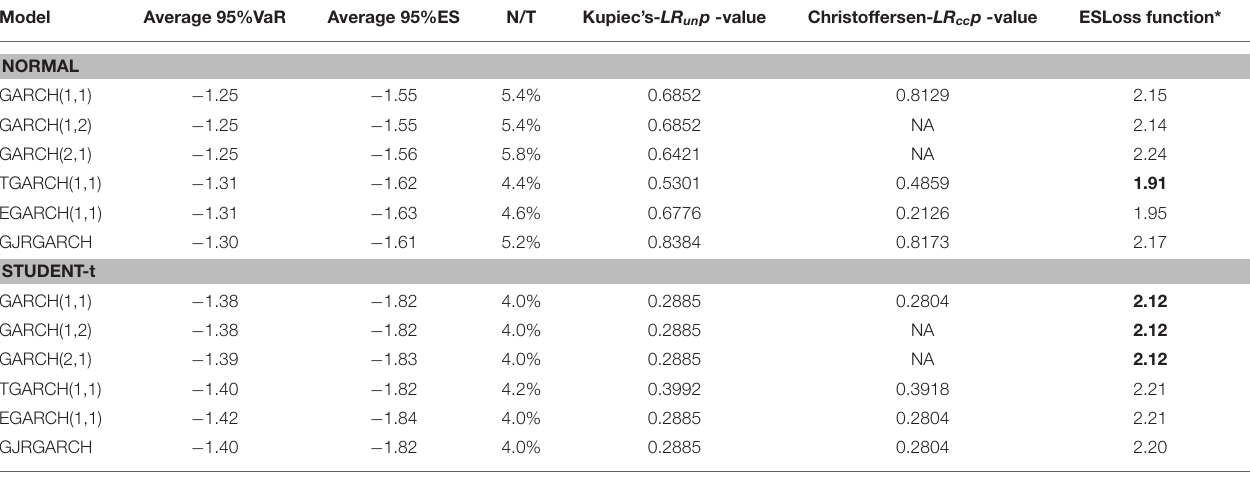
TABLE 8 | FTSE equity index: 95%VaR and 95%ES average values of one-day-ahead forecasts, percentages of violation (N/T), Kupiec’s and Christoffersen’s p -values and ES loss function. Model